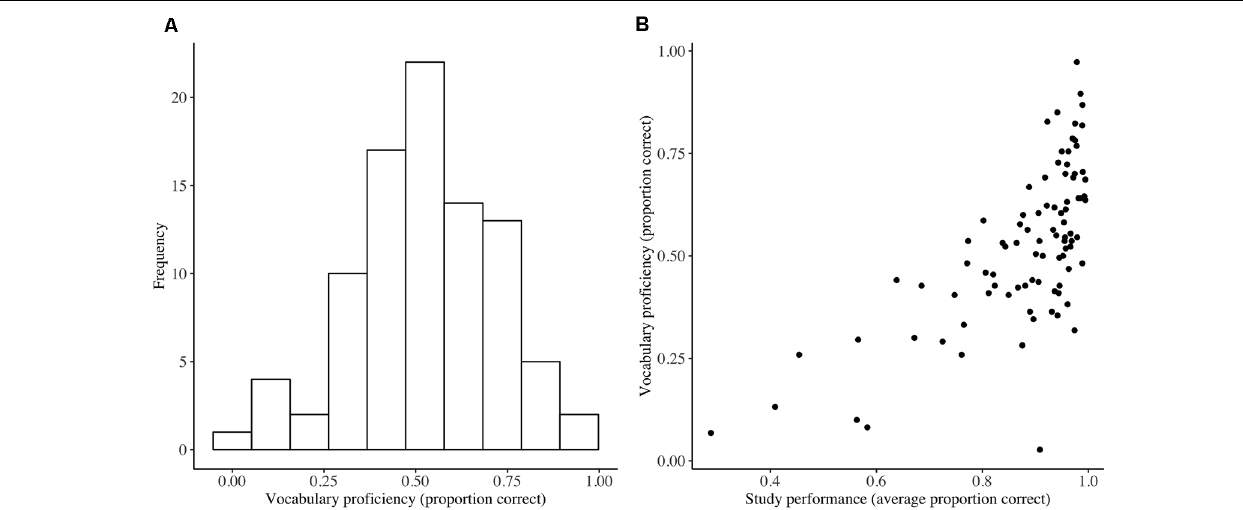
FIGURE 3 | Vocabulary test performance (A) and its relationship with study performance (B) . Distribution of performance on the final vocabulary test at the end of language training (vocabulary proficiency) and a scatterplot demonstrating the association between vocabulary proficiency and average performance on the weekly homework ( n = 90).